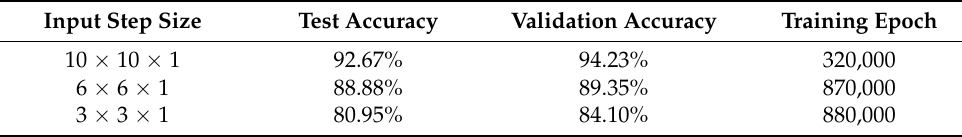
Table 2. Test accuracy results for EPSON IMU accelerometer.